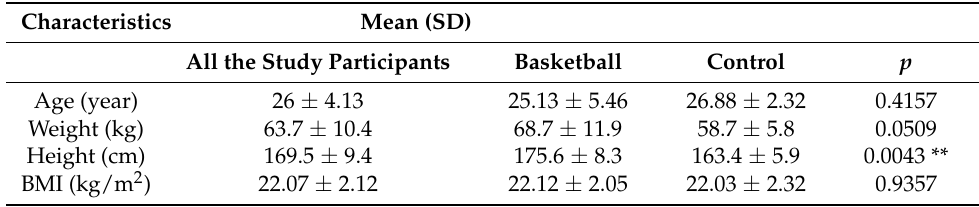
Table 1. Participants’ characteristics.